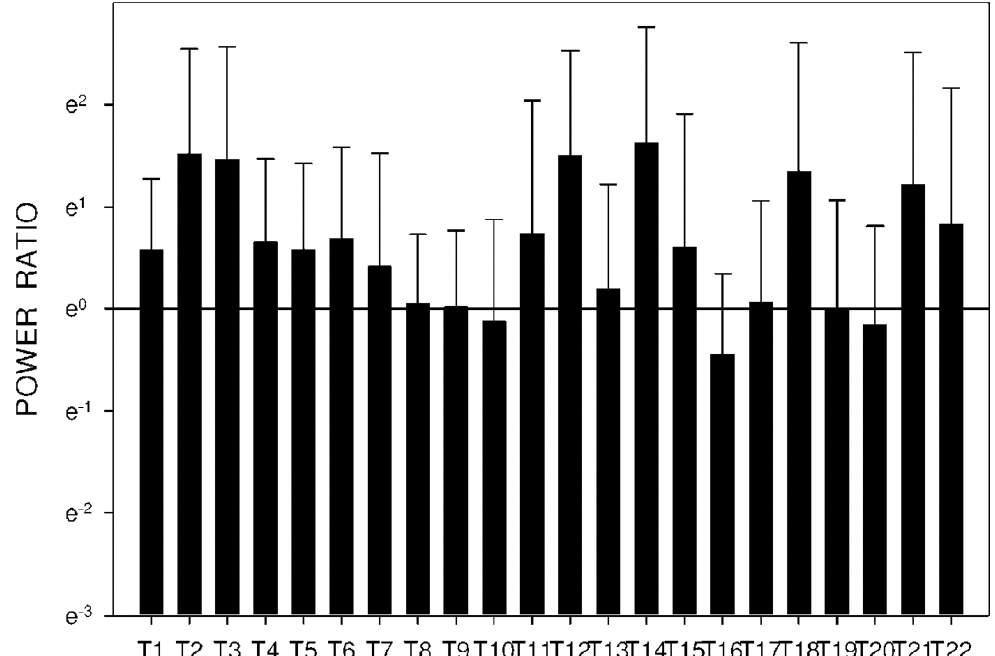
Figure 15. Electrogastrography power ratio after a single intragastric dose of 10 mg of donepezil (group B). Outliers omitted. Y axis: natural log scale.